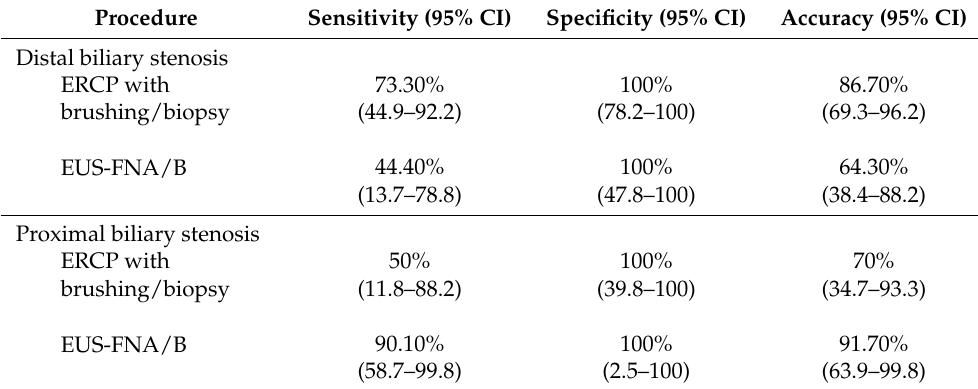
Table 3. Diagnostic yield of ERCP with brushing/biopsy and EUS-FNA/B according to site of biliary stenosis.